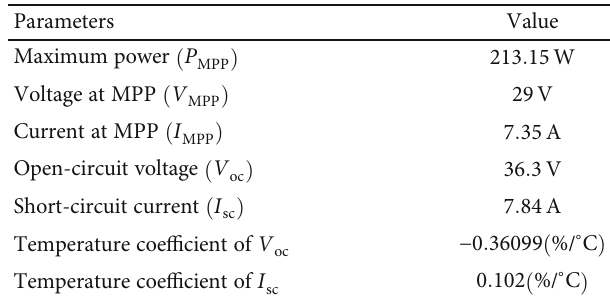
Figure 16: Schematic of the proposed PV system with MPPT algorithm. Table 1: Parameter of the 1Soltech 1STH-215-P PV module at STC: temperature = 25 ° C and insolation = 1000 W/m 2